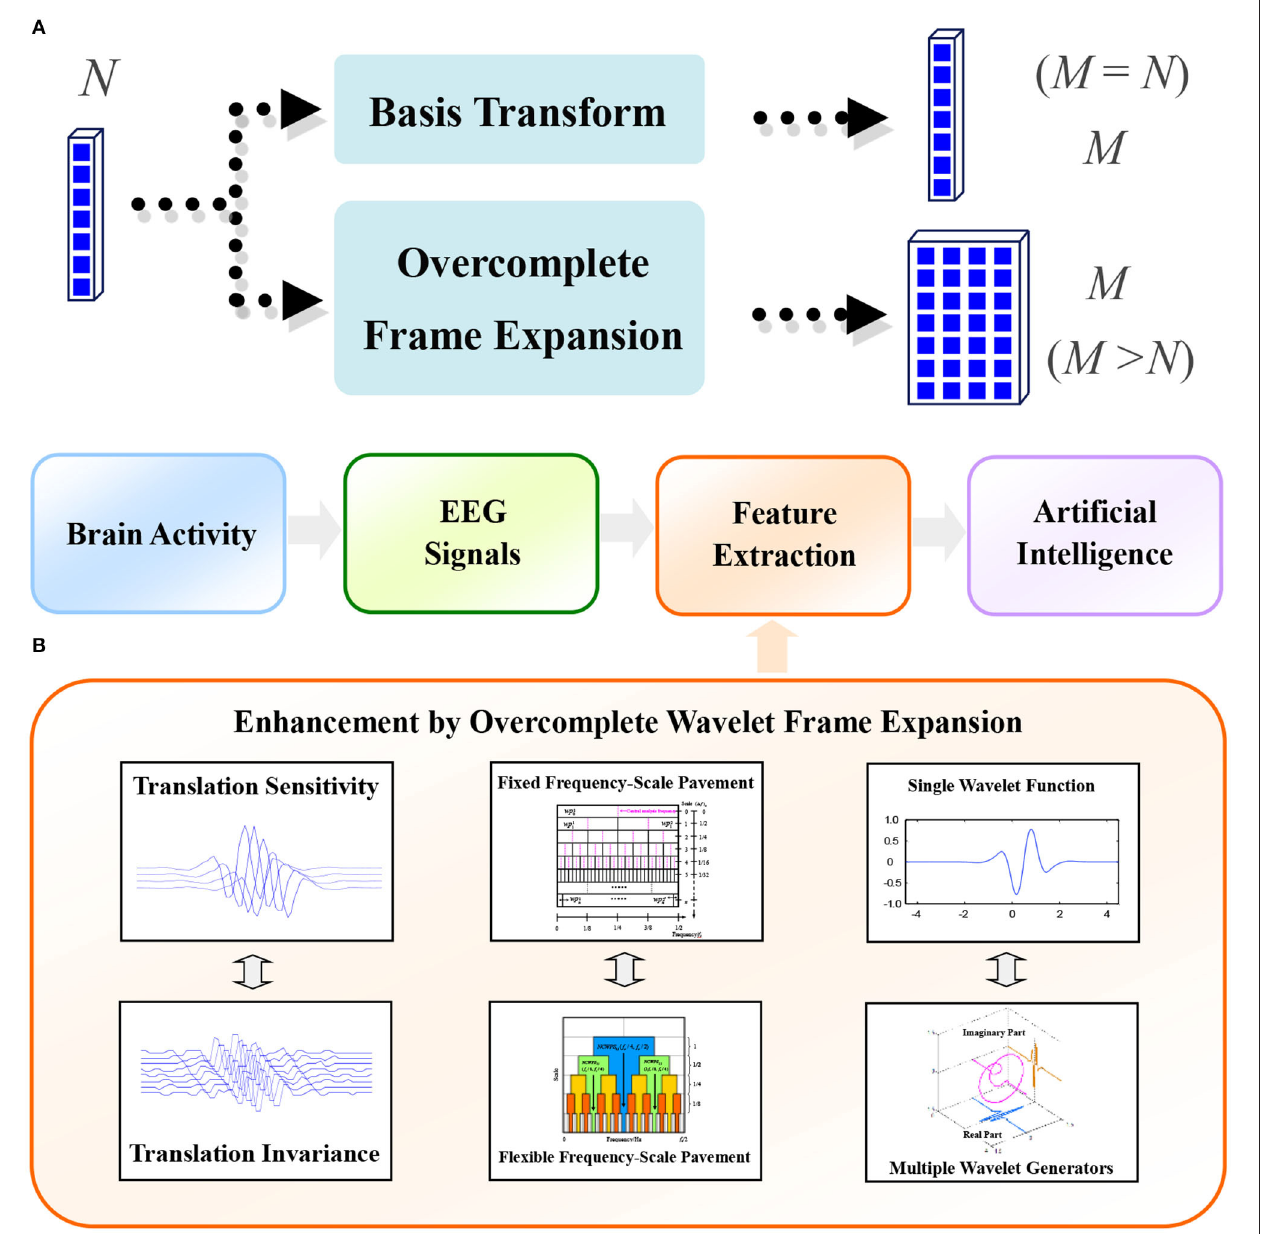
FIGURE 1 | (A) Fundamentals of overcomplete wavelet frame expansion, where N is the number of samples in the input signal and M is the number of samples in the output signal; and (B) A framework to illustrate the enhancement of wavelet decomposition for EEG-based information mining.